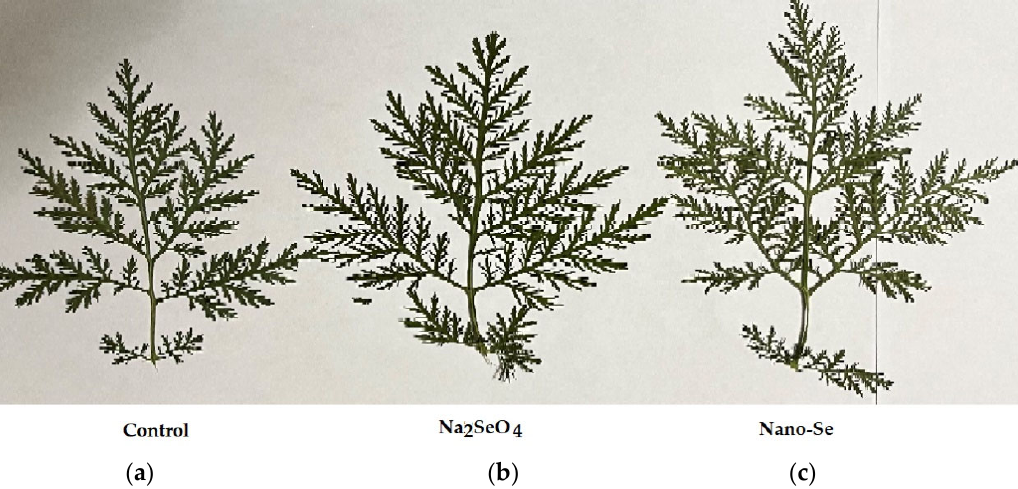
Figure 1 . A. annua leaves without Se supply ( a ) and biofortified with sodium selenate ( b ) and nano ‐ Se ( c ). Table 1. Morphological characteristics of A. annua